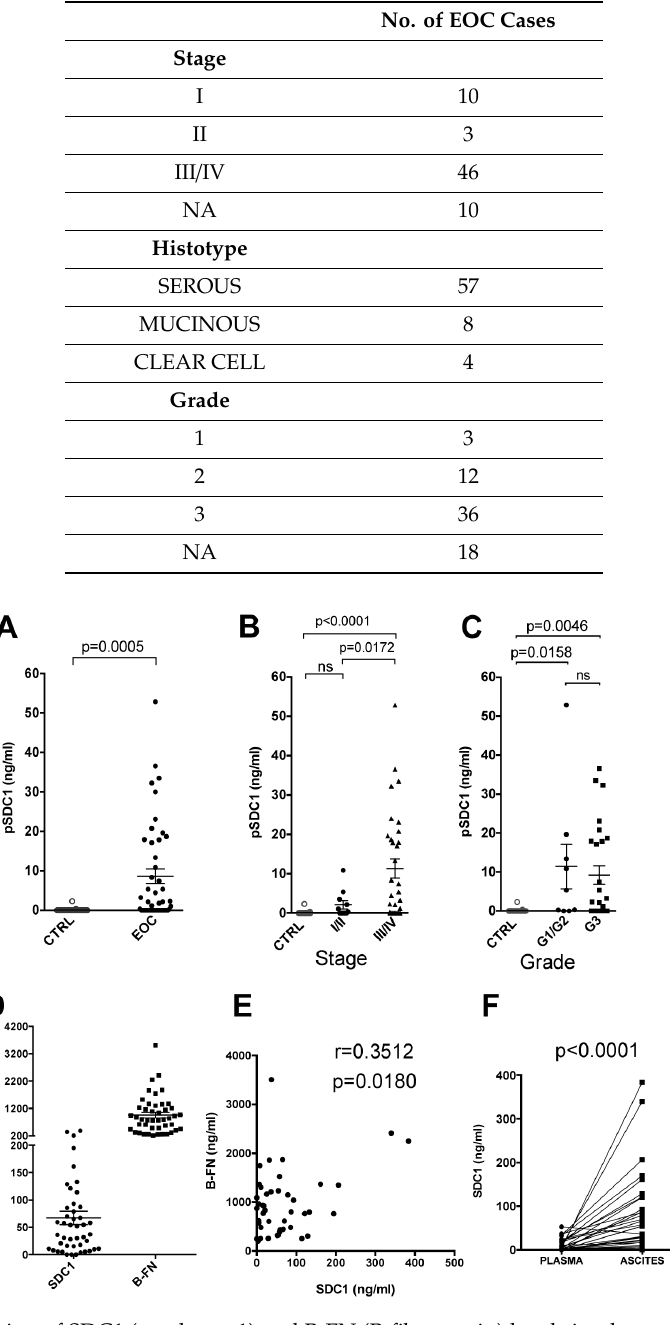
Figure 1. Evaluation of SDC1 (syndecan-1) and B-FN (B-fibronectin) levels in plasma and ascites from EOC patients. ( A ) SDC1 plasma (pSDC1) levels in EOC patients (n = 45) were significantly higher